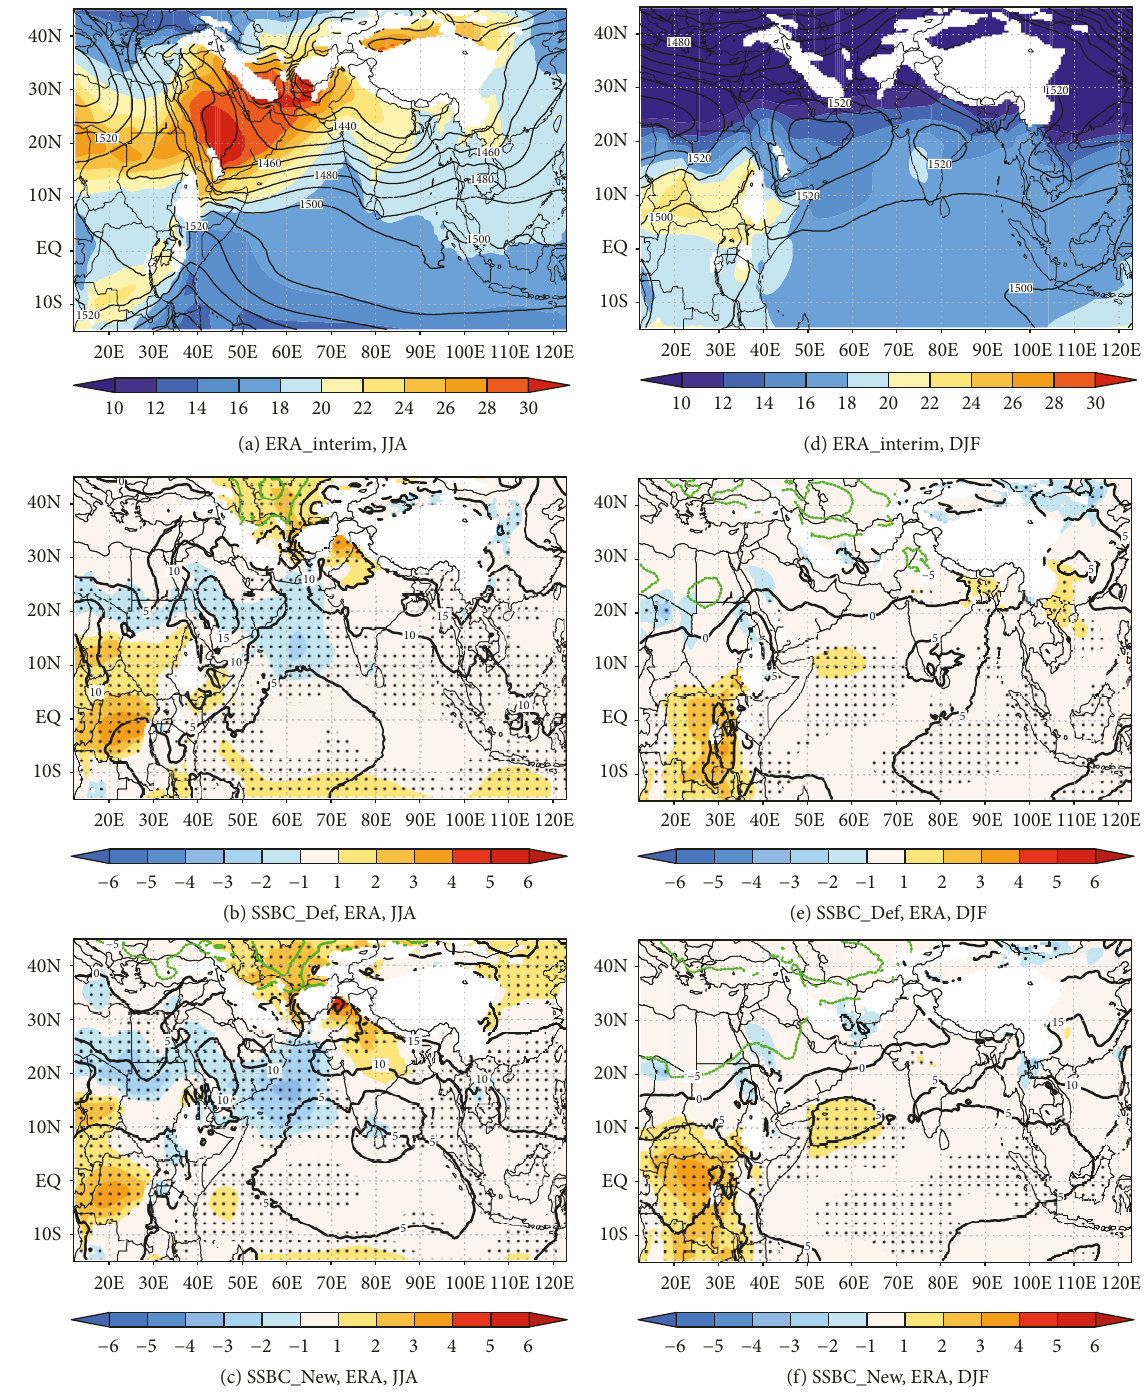
Figure 10: The same as Figure 9 but for the 850 hPa geopotential height (contour, m) and the air temperature (shaded, ∘ C) difference between JJA and DJF, 1981–1990. The red color is for warm and the blue is for cold bias. The statistically significant regions at 99% confidence level shaded as black dots. The solid black contour is for positive and the green is for negative geopotential height bias, respectively.